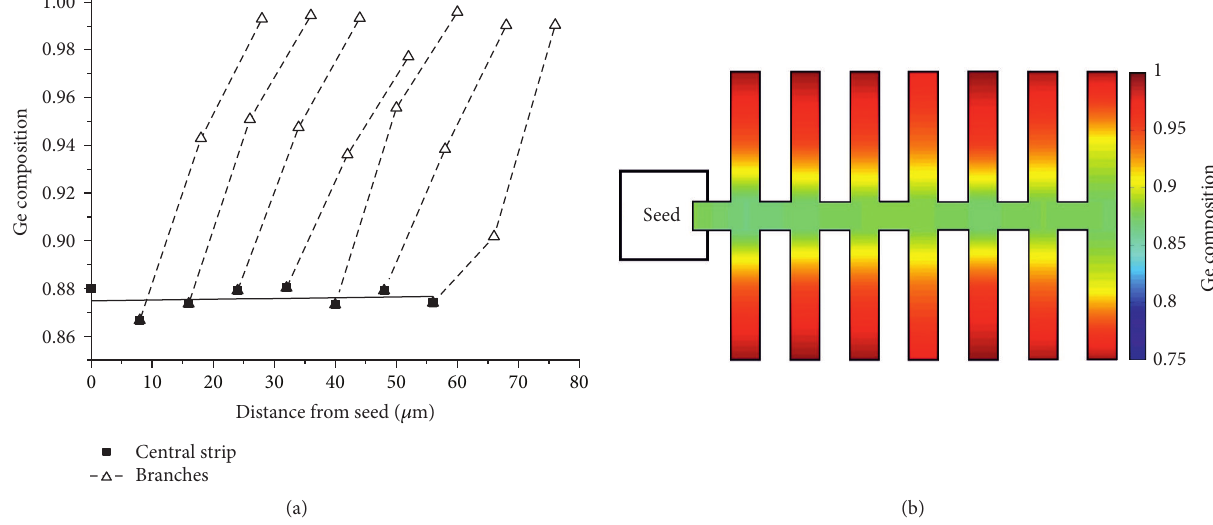
Figure 10: SiGe composition profile of a tailored tree-like structure. (a) Graph and (b) schematic. C = 20 𝜇 m, and B = 3 𝜇 m. The final set of branches have been omitted to display only the uniform composition region. Estimated maximum S SiGe temperature = 975 ∘ C. A linear fit has been added to the central